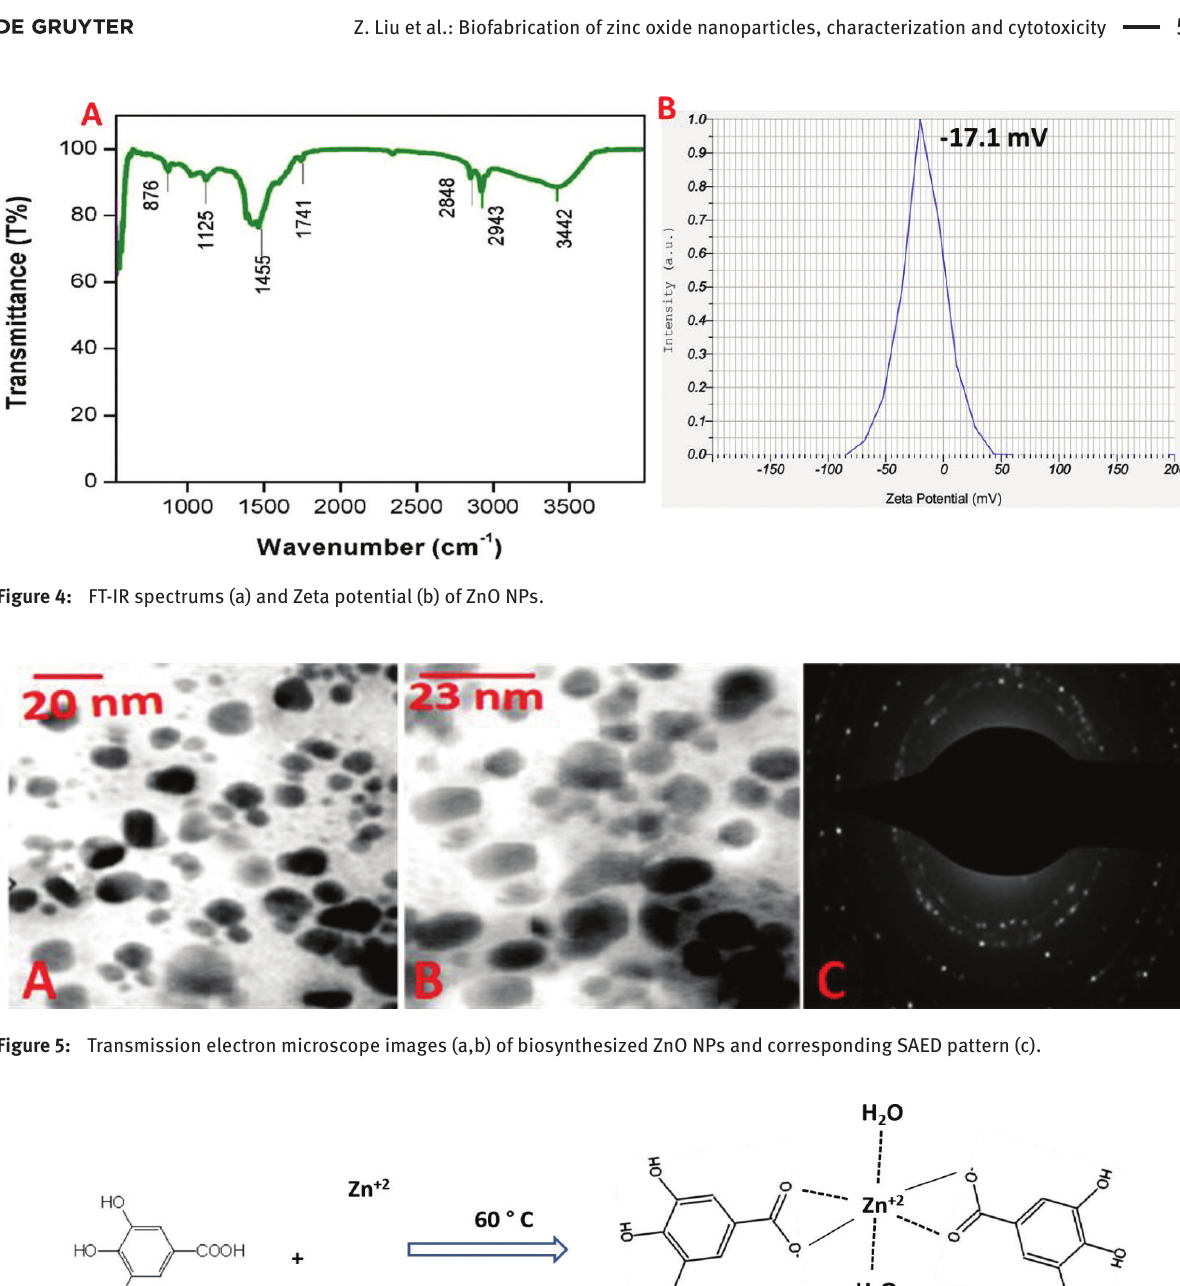
and oval with sizes differing from 3 to 29 nm and the